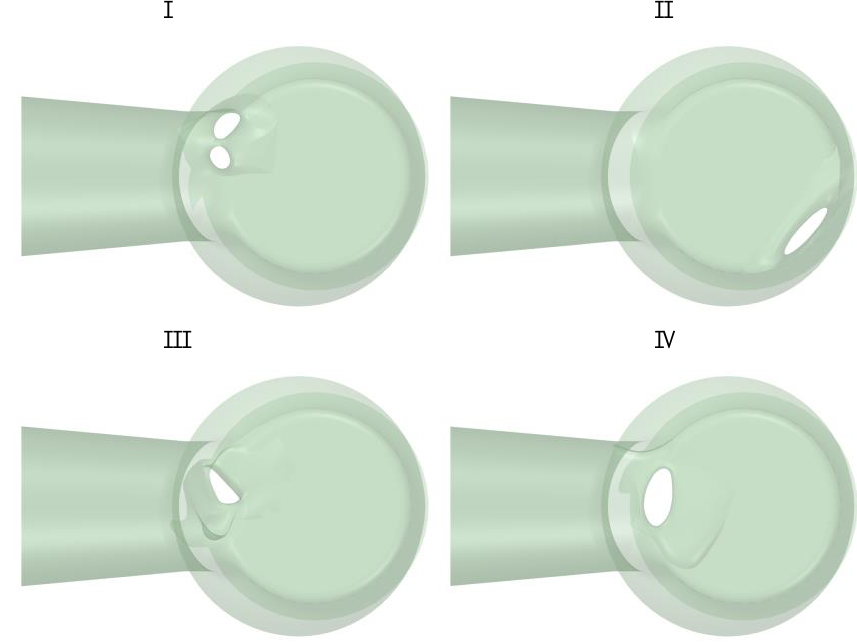
Figure 2. Simplified model of the left ventricle.